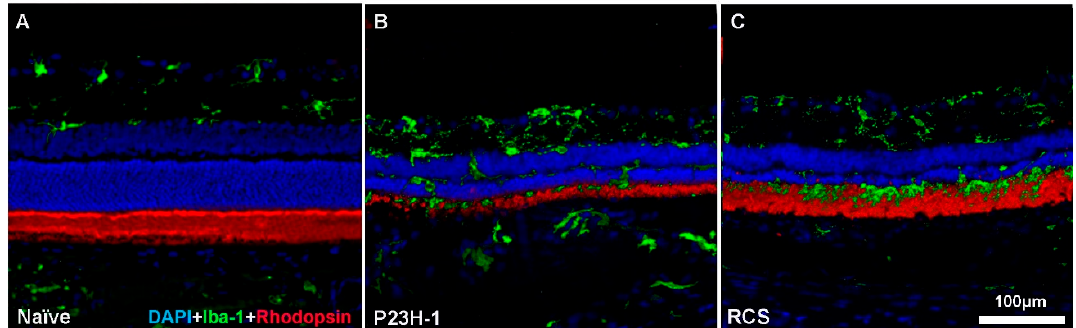
Figure 1. Rod degeneration and microglial cell responses. Microphotographs of representative retinal cross sections from a naïve SD rat ( A ) showing a normal retina, a retina from a P23H-1 rat ( B ) and a retina from an RCS rat ( C ) in the early stages of retinal degeneration. Rod outer segments appear in red and microglial cells in green. In the P23H-1 rat retina, rhodopsin expression was clearly affected; however, in the RCS rat, rhodopsin expression is not altered since the retinal pigment epithelium (RPE) cells are not phagocytising the rod outer segment debris. In both experimental retinas, microglial cells were activated and migrated from the inner to the outer retinal layers.